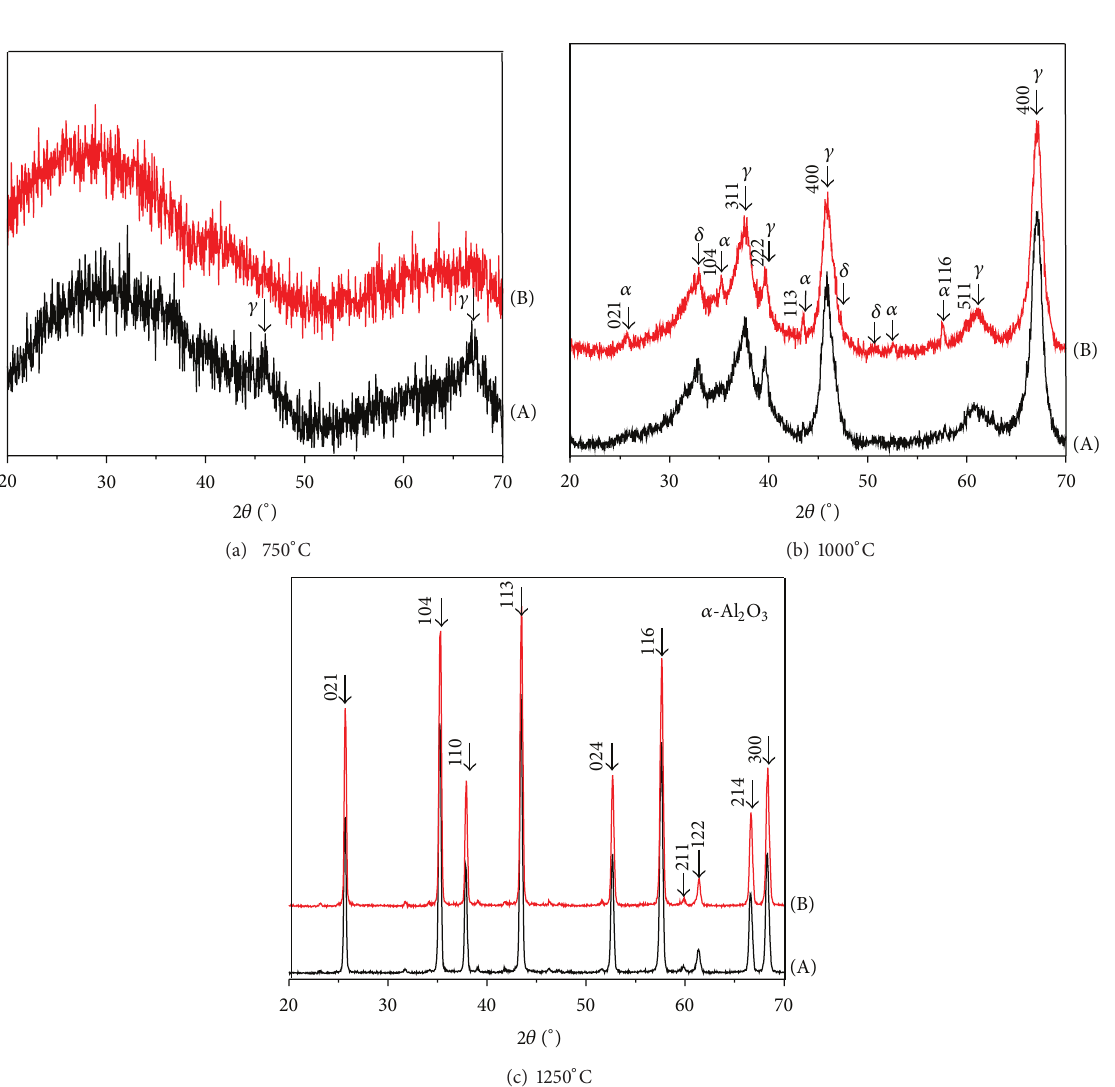
Figure 2: XRD patterns of Al 2 O 3 nanopowder prepared with complexing agent. (A) Citric acid and (B) urea calcined at temperatures of (a) 750 ∘ C, (b) 1000 ∘ C, and (c) 1250 ∘ C.